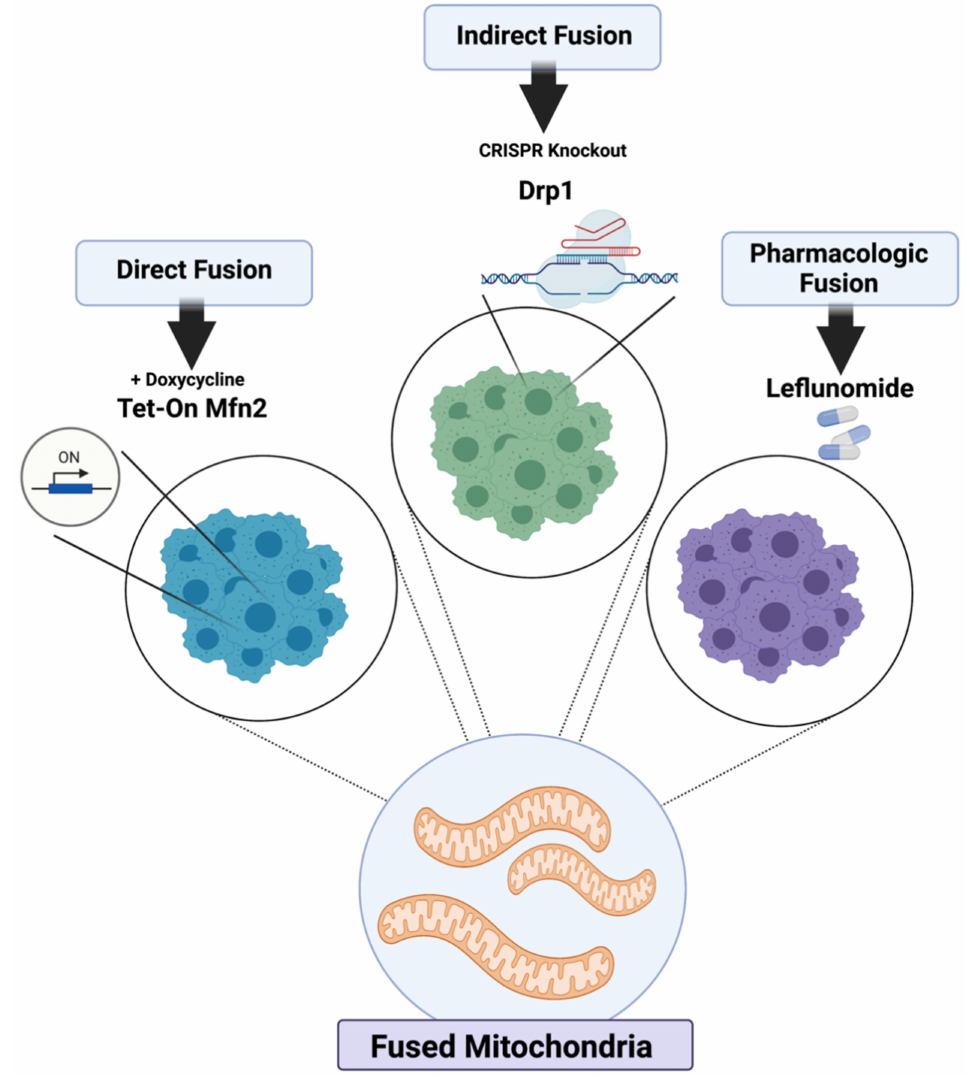
Figure 1. Models of mitochondrial fusion induction. KPC cells were genetically modified to directly overexpress Mfn2 in a tetracycline-inducible manner, indirectly fuse through CIRSPR knockout of Drp1, and pharmacologically fuse after treatment with